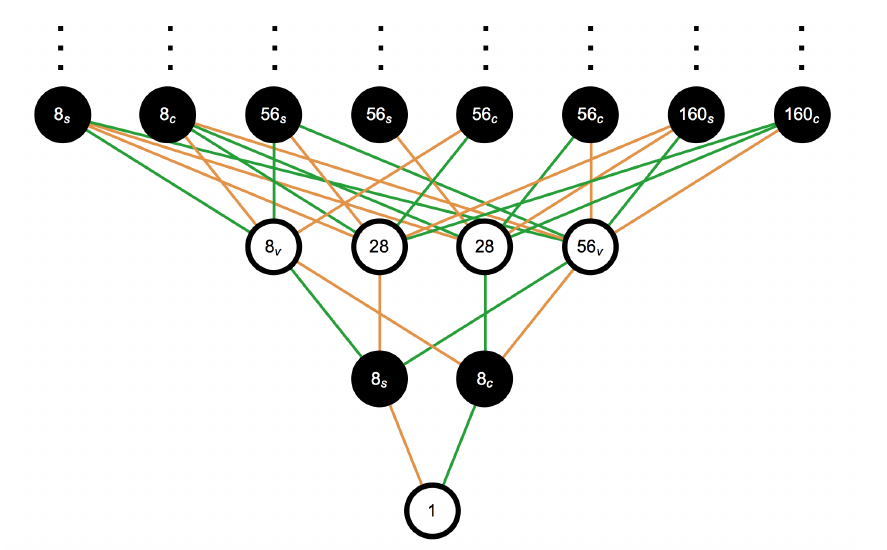
Figure 4 . Adinkra Diagram for 8D minimal scalar